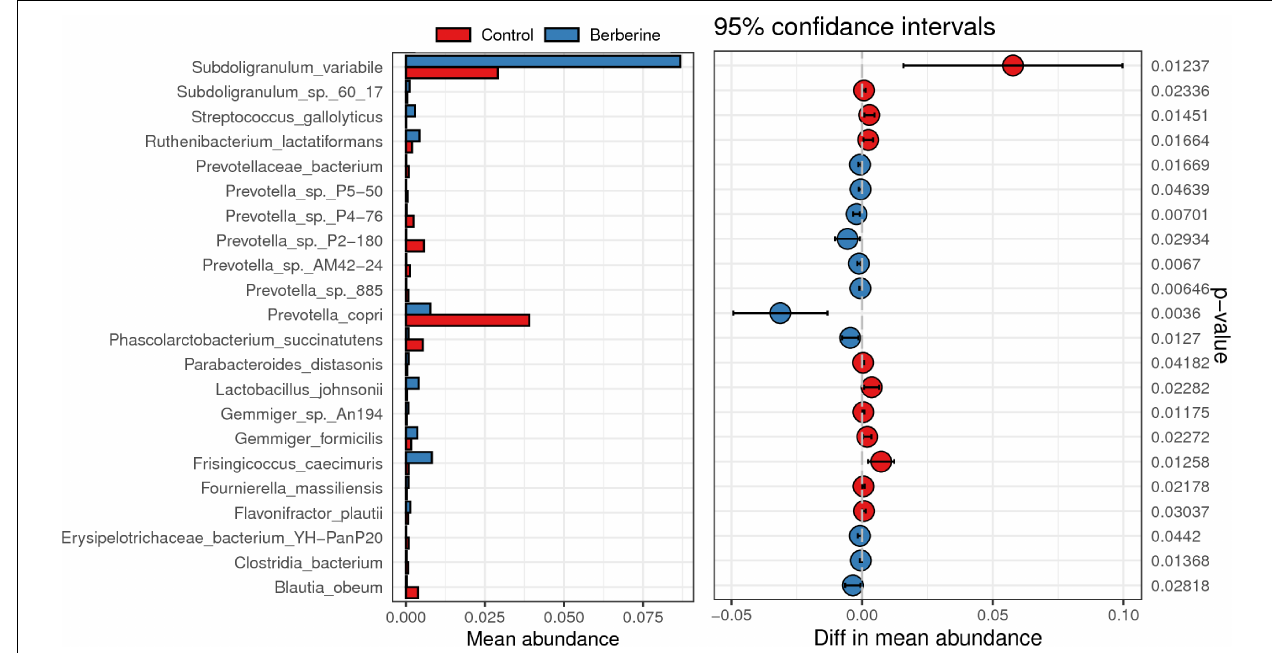
FIGURE 4 | Welch t -test of berberine on microbial species of pig gut